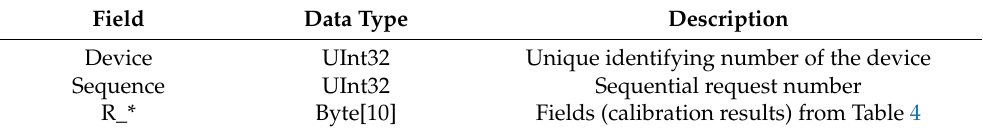
Table 5. Request for tuning message.